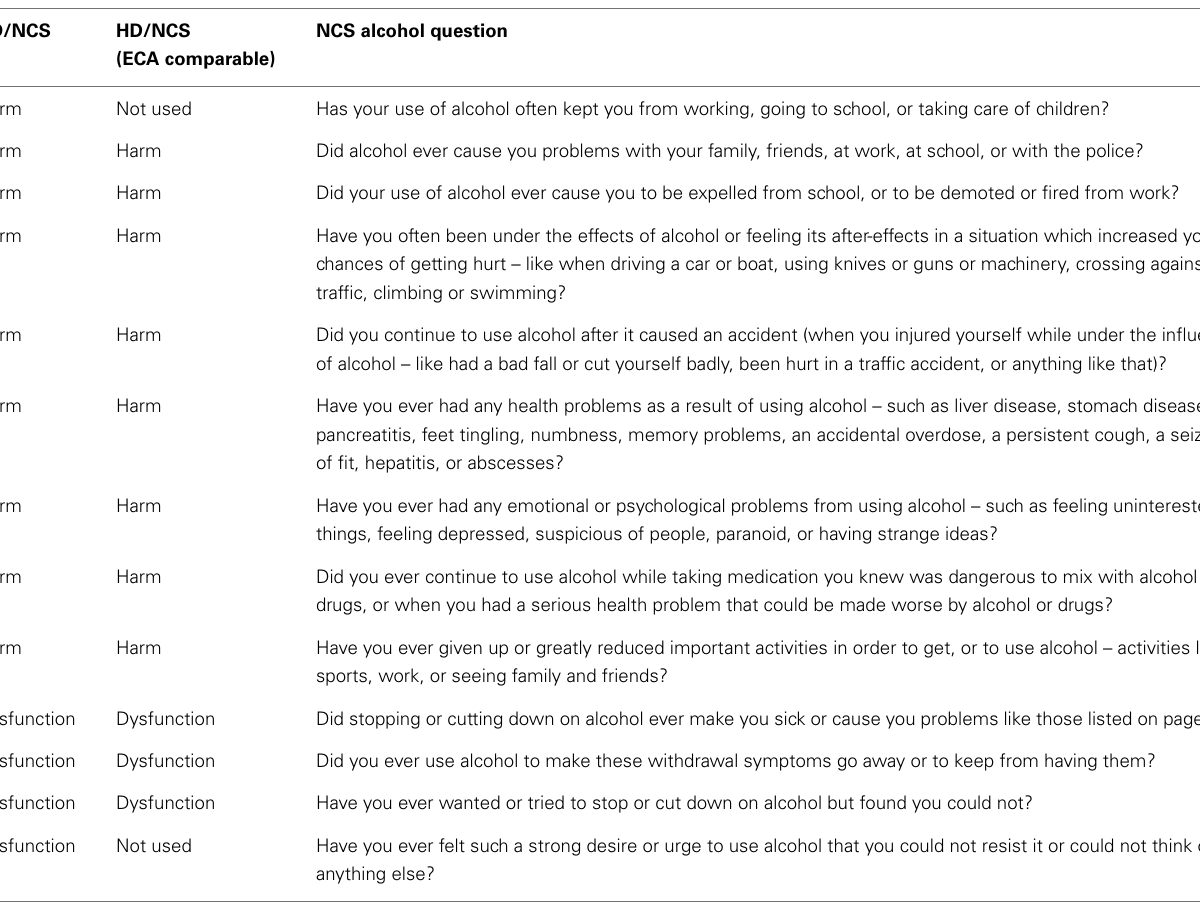
TableA4 | Harmful dysfunction (HD) diagnostic categories of harm and dysfunction and how they were translated using National Comorbidity Survey (NCS) questions